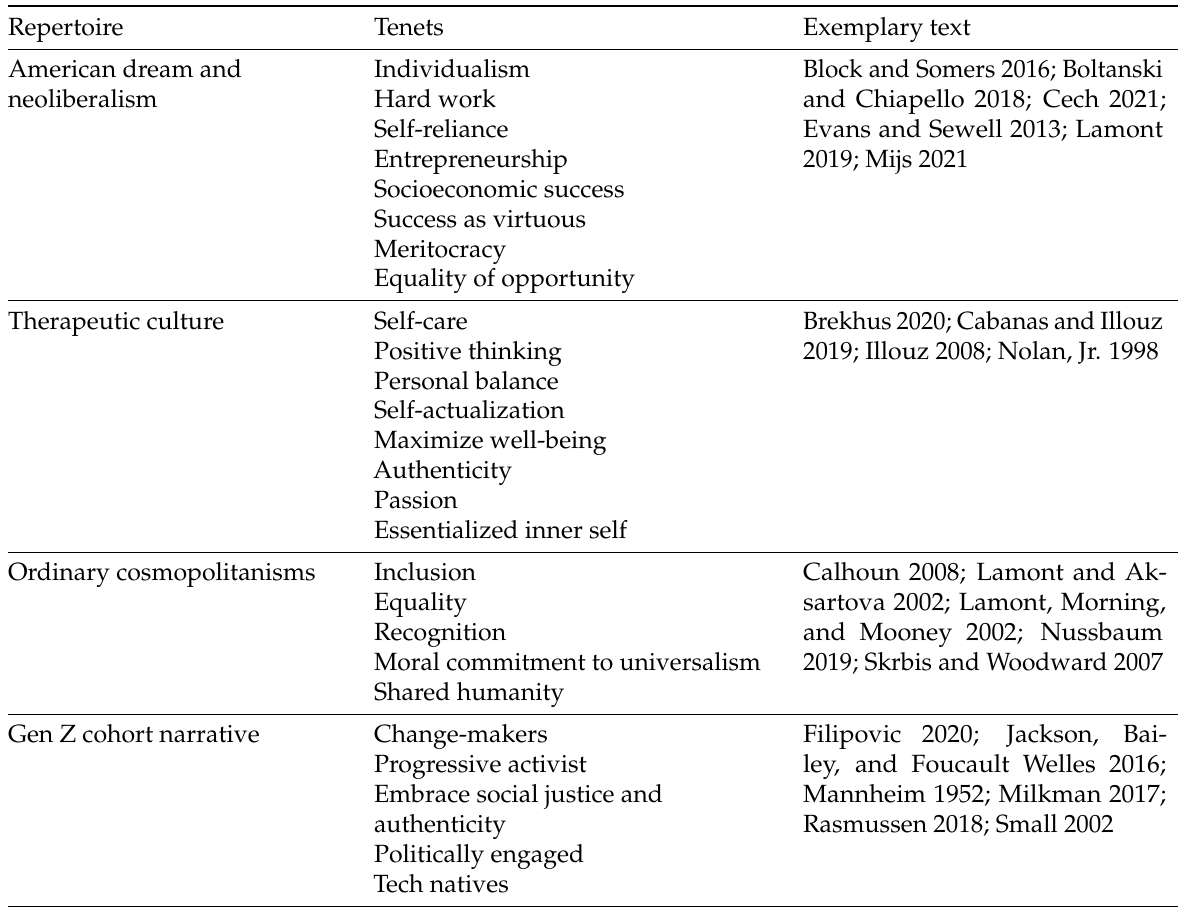
Table 1: Key cultural repertoires